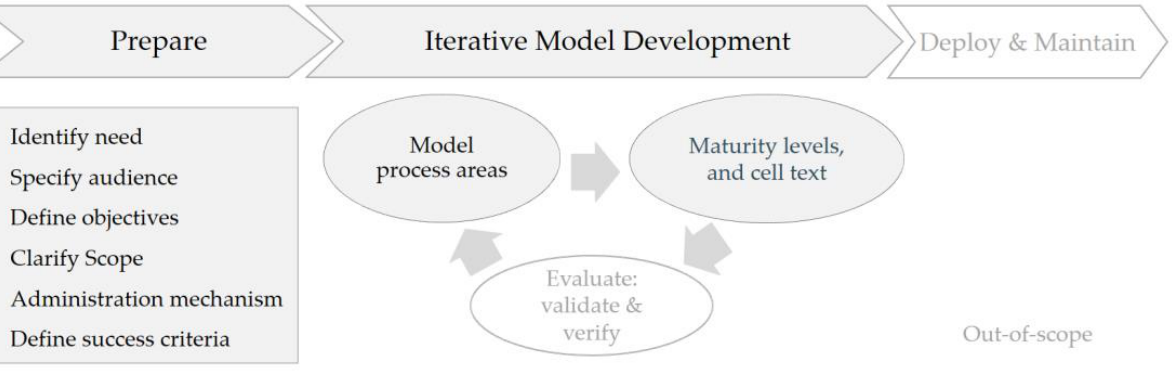
Figure 4. Model building blocks (adapted from Maier et al. (2012) [30]).